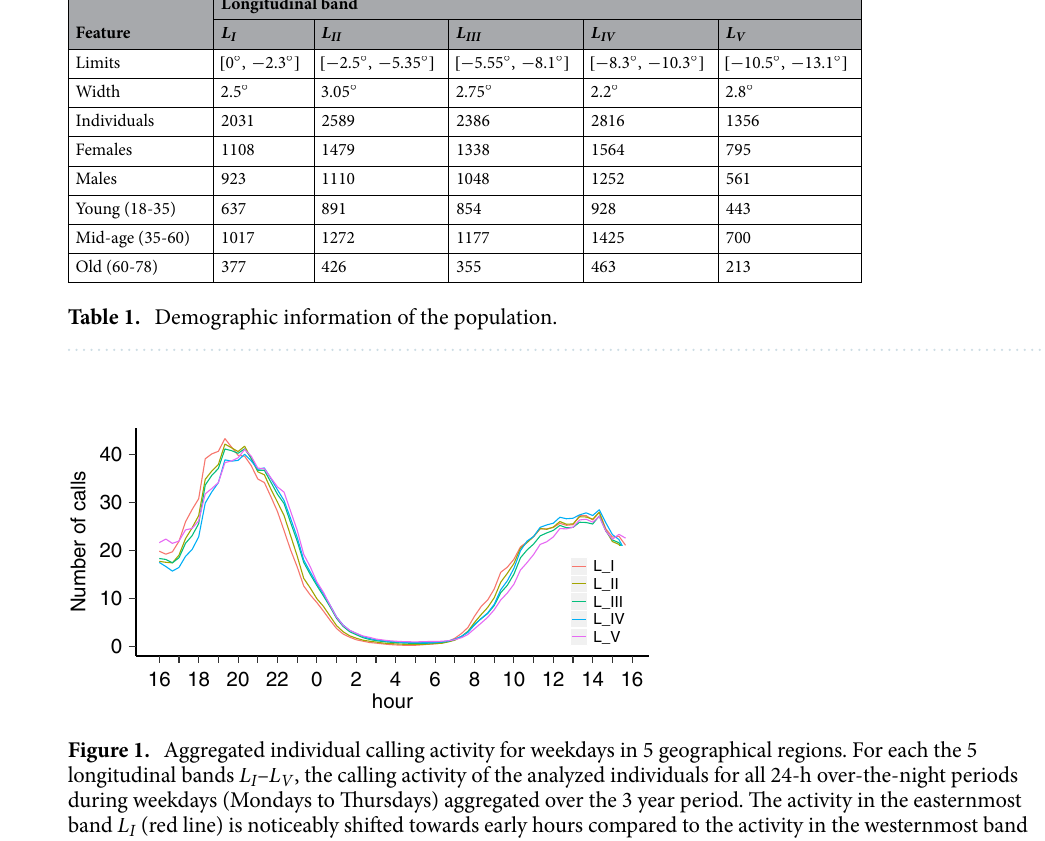
0 , 2.3 2.5 , 5.35 5.55 , 8.1 ◦ ◦ ] , L II : [− ◦ ◦ ] , L III : [− ◦ ◦ ] , : [ − − −